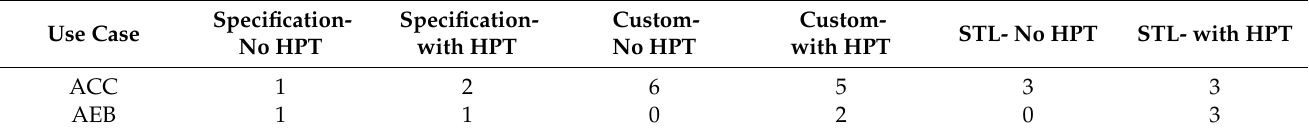
Table A2. Result of hyperparameters on reward type on ACC.